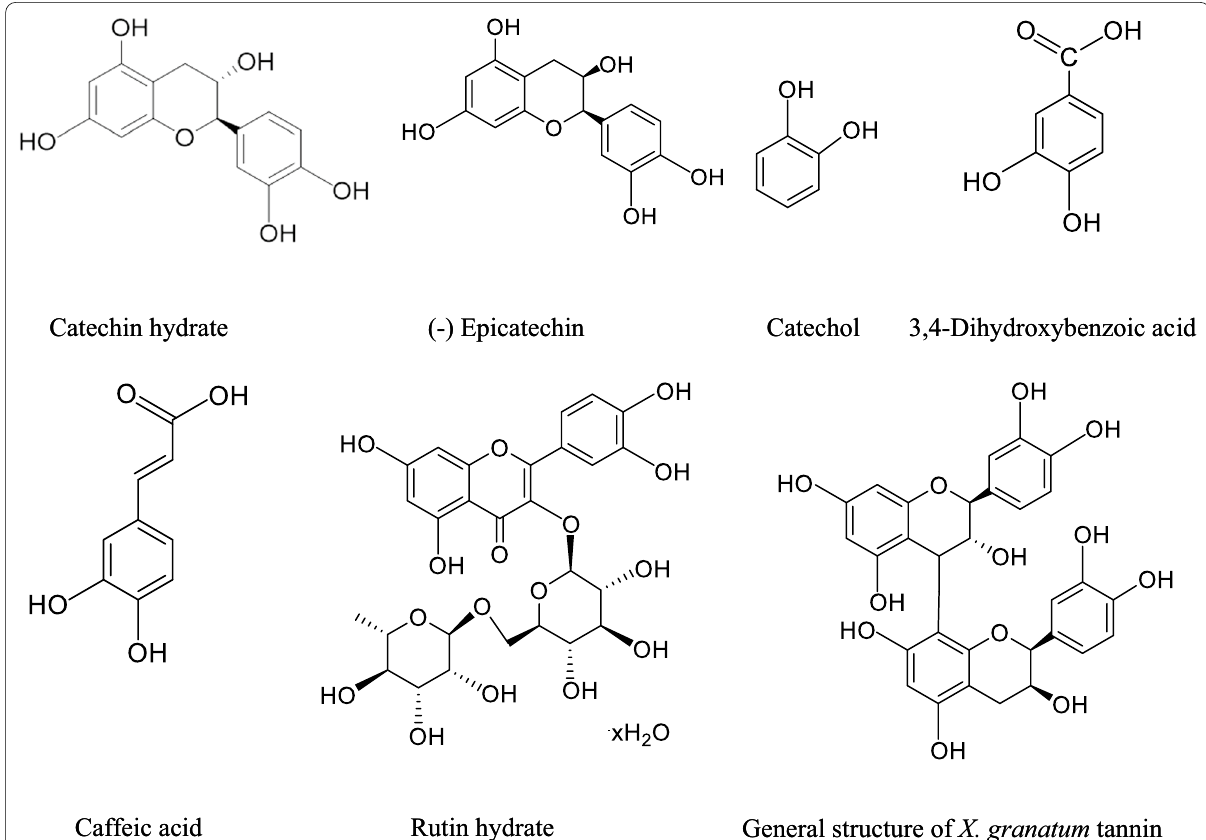
Fig. 6 Structure of polyphenolic compounds in the X. granatum tannin